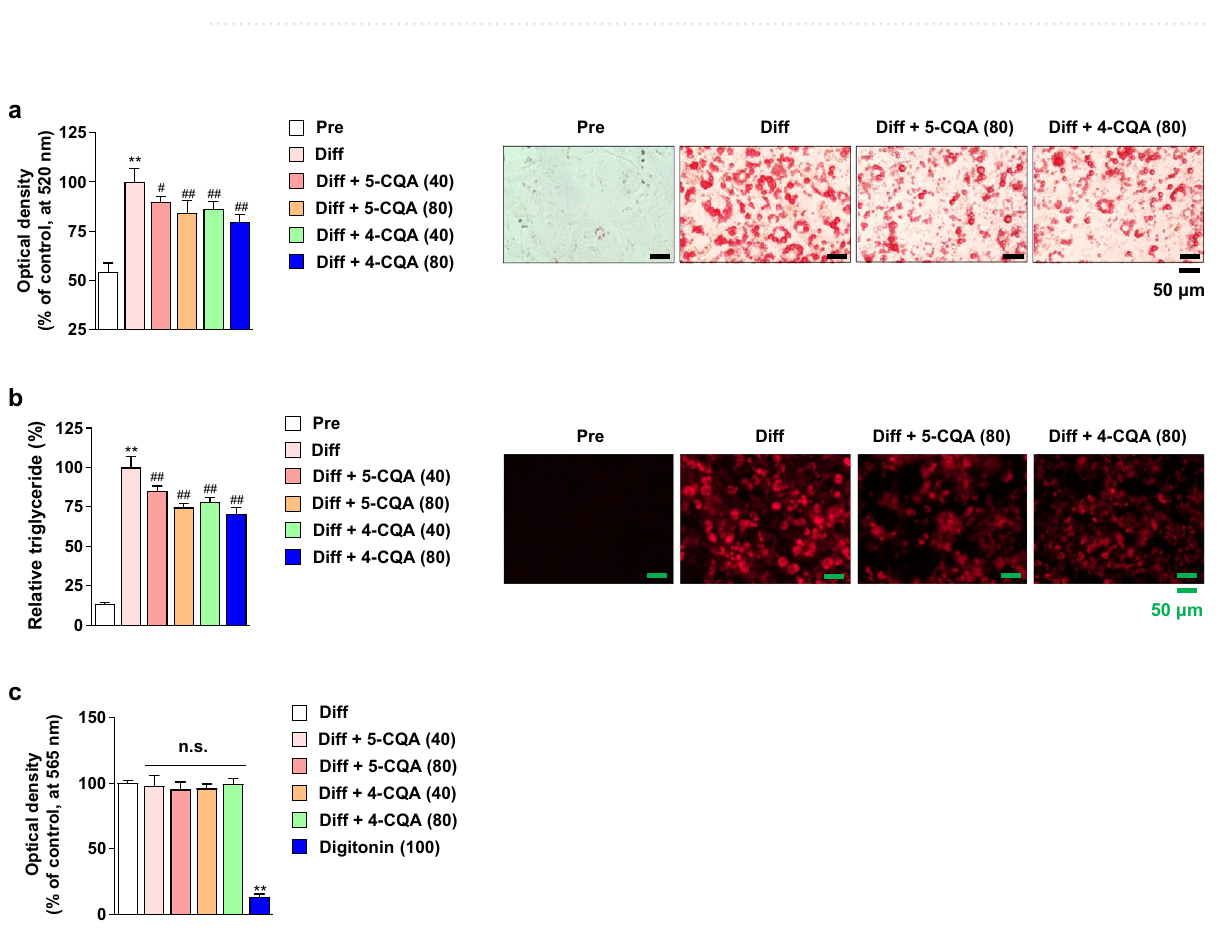
Figure 4. Effects of neochlorogenic acid (5-CQA) and cryptochlorogenic acid (4-CQA) on lipid accumulation, triglyceride accumulation, and cytotoxicity in 3T3-L1 cells. ( a ) Effect of 5-CQA and 4-CQA on lipid accumulation in 3T3-L1 cells. 5-CQA (40 and 80 μM) and 4-CQA (40 and 80 μM) were treated with 3T3-L1 adipocytes during differentiation periods. Oil red O staining was performed as described in the Materials and methods section. Pre: preadipocytes, Diff: 8-day differentiated cells. ( b ) Effect of 5-CQA and 4-CQA on triglyceride accumulation in 3T3-L1 cells. 5-CQA (40 and 80 μM) and 4-CQA (40 and 80 μM) were treated with 3T3-L1 adipocytes during differentiation periods. Nile red staining was performed as described in the Materials and methods section. Pre: preadipocytes, Diff: 8-day differentiated cells. ( c ) Effects of 5-CQA or 4-CQA